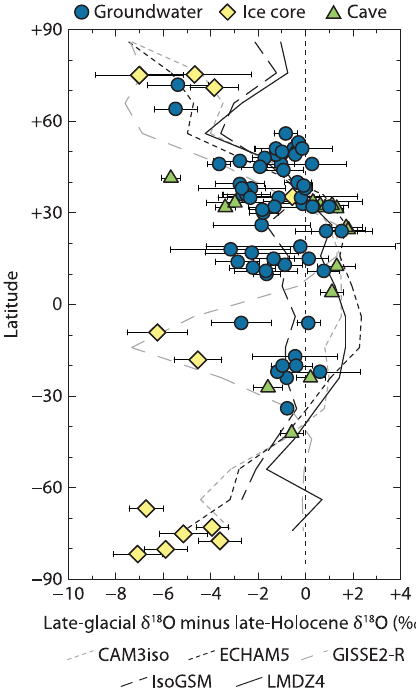
Figure 3. Latitudinal variations of (cid:49) 18 O late-glacial values of groundwater (circles, each circle is one aquifer), ice cores (dia- monds) and cave calcite (i.e., triangles; where (cid:49) 18 O late-glacial = δ 18 O late-glacial − δ 18 O late-Holocene ). Dashed lines mark 10 ◦ zonal mean simulated (cid:49) 18 O late-glacial values from five different gen- eral circulation models: CAM3iso, ECHAM5-wiso, GISSE2-R, IsoGSM and LMDZ4 (Yoshimura et al., 2003; Legrande and Schmidt, 2008, 2009; Risi et al., 2010a; Noone and Sturm, 2010; Pausata et al., 2011a; Werner et al.,